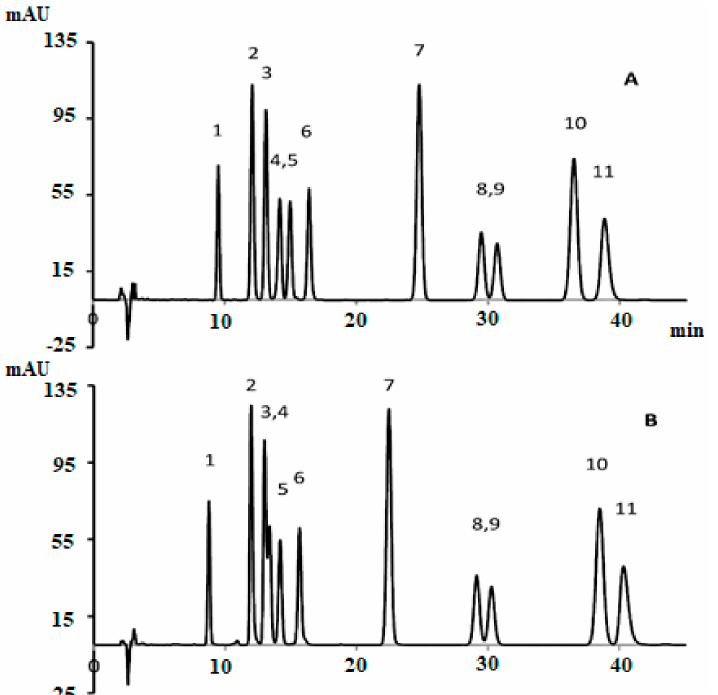
Figure 8. HPLC profile of 11 cannabinoids using an analytical column, ( A ) ACE 5 C18-AR (250 mm × 4.6 mm ID, 5 µ m) and ( B ) conventional c-18 column [20]. Elution order: 1-CBDV, 2-CBDA, 3-CBGA, 4-CBG, 5-CBD, 6-THCV, 7-CBN, 8-d9THC, 10-CBC, and 11-THCA. Reprinted with permission from Ref. [20]. Copyright 2021 Copyright